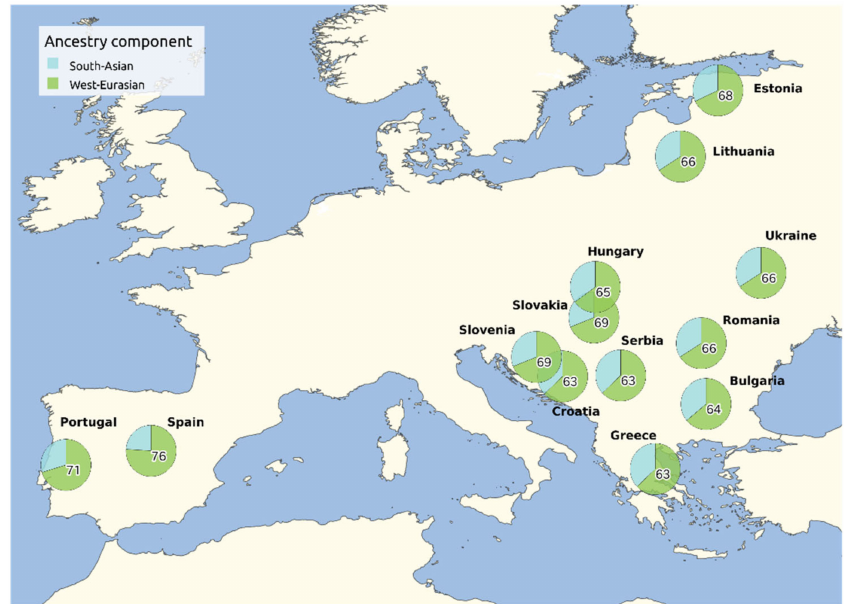
Figure 2. South Asian and West Eurasian ancestry components in Romani groups based on the results from Font-Porterias et al., 2019. The weighted means for the individuals obtained in the original analysis by genetic clusters are regrouped by country of origin. For sake of clarity, only West Eurasian ancestry percentages are